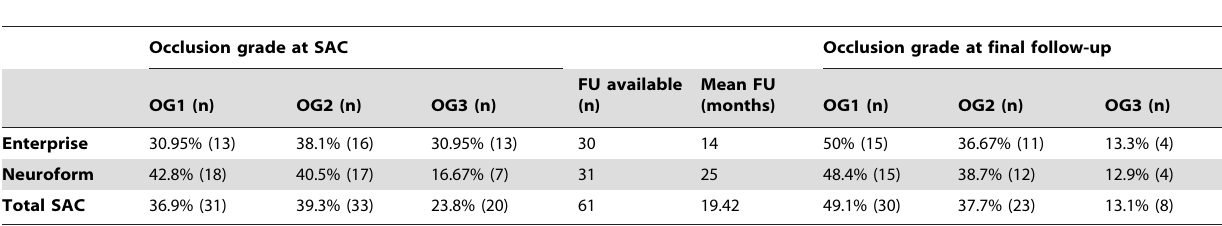
Table 4. Initial angiographic outcome of aneurysms coiled with stent-assistance using the Neuroform or Enterprise stent and occlusion grade at final angiographic